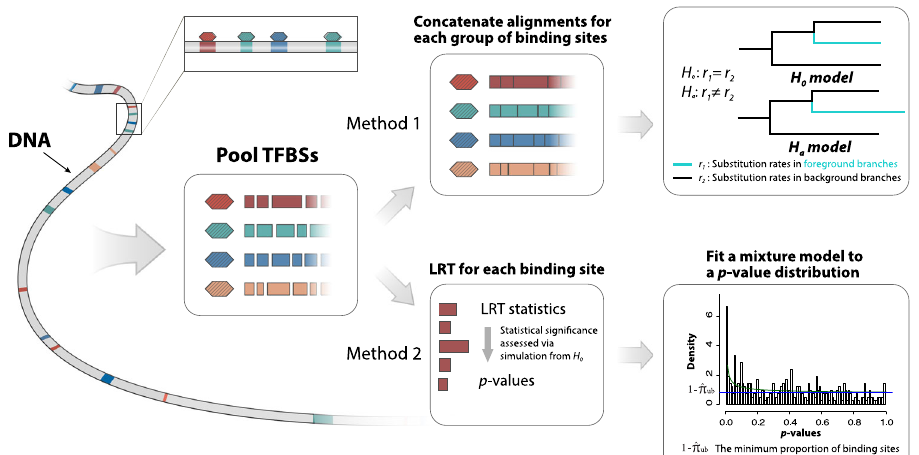
Fig.1|Pooling-basedphylogeneticmethodsforinferringacceleratedevolution in TFBSs. In the fi rst method, we fi t the group-level LRT to the concatenated alignment of TFBSs bound by the same transcription factor, which allows us to examinewhetherthegroupofTFBSsasawholeevolvedatanelevatedsubstitution rate inthe foreground lineage compared to the background lineage. In the second method, we fi t the element-level LRT to the alignment of each individual TFBS,